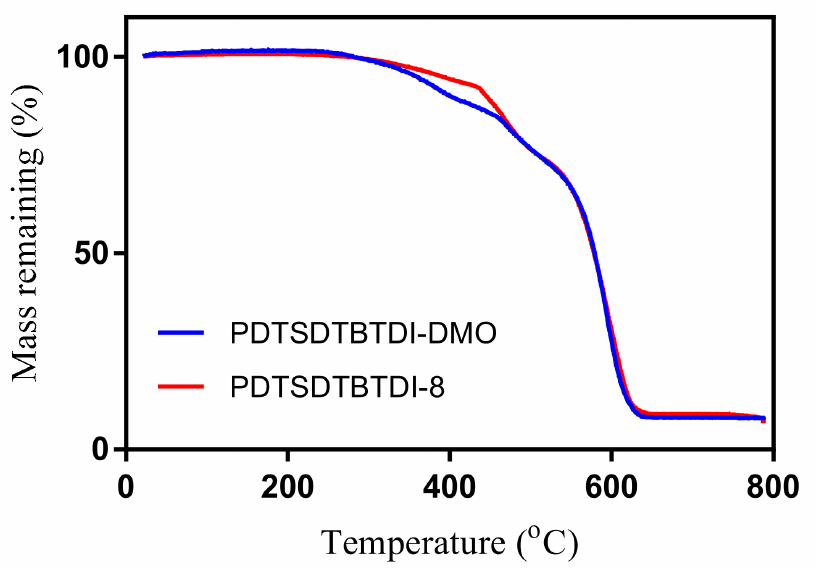
Figure 3. TGA of PDTSDTBTDI-DMO and PDTSDTBTDI-8. PDTSDTBTDI-DMO and PDTSDTBTDI-8 were found to have slightly higher decom- position temperatures than those observed for PDTSDTTTz-4 and PDTSNTDO (317 ◦ C and 321 ◦ C, respectively). PDTSDTBTDI-8 was found to have better thermal stability compared to PDTSDTBTz and PDTSTAZ (368 and 388 ◦ C,